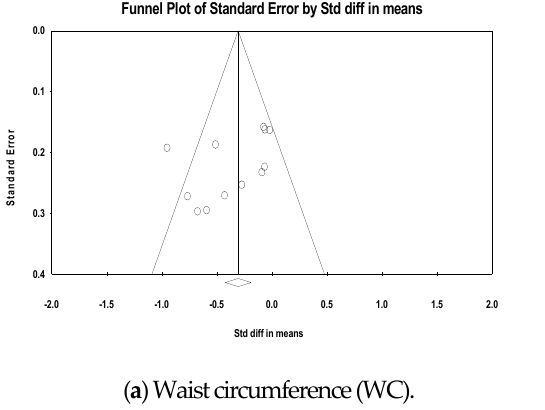
Funnel Plot of Standard Error by Std diff in means